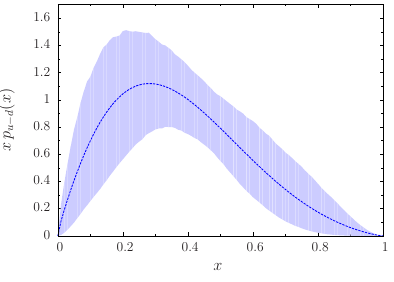
( u − d ) for Q 2 = 2.7GeV 2 val